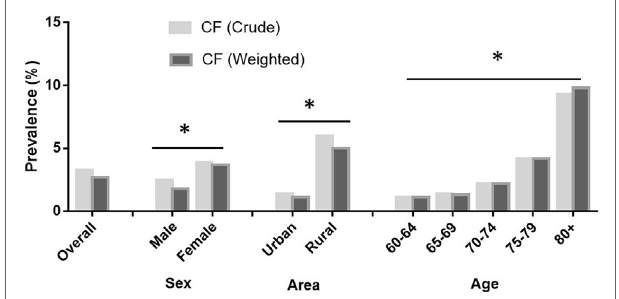
FigUre 1 | Prevalence of cognitive frailty (CF) in older adults by gender, area, and age. The prevalence of CF among adults aged 60 + in China by China Comprehensive Geriatric Assessment Study, 2011–2012. Data were weighted by the national standard population composition ratio based on the Sixth National Census (2010). The total sample population in the analysis was 5,708.